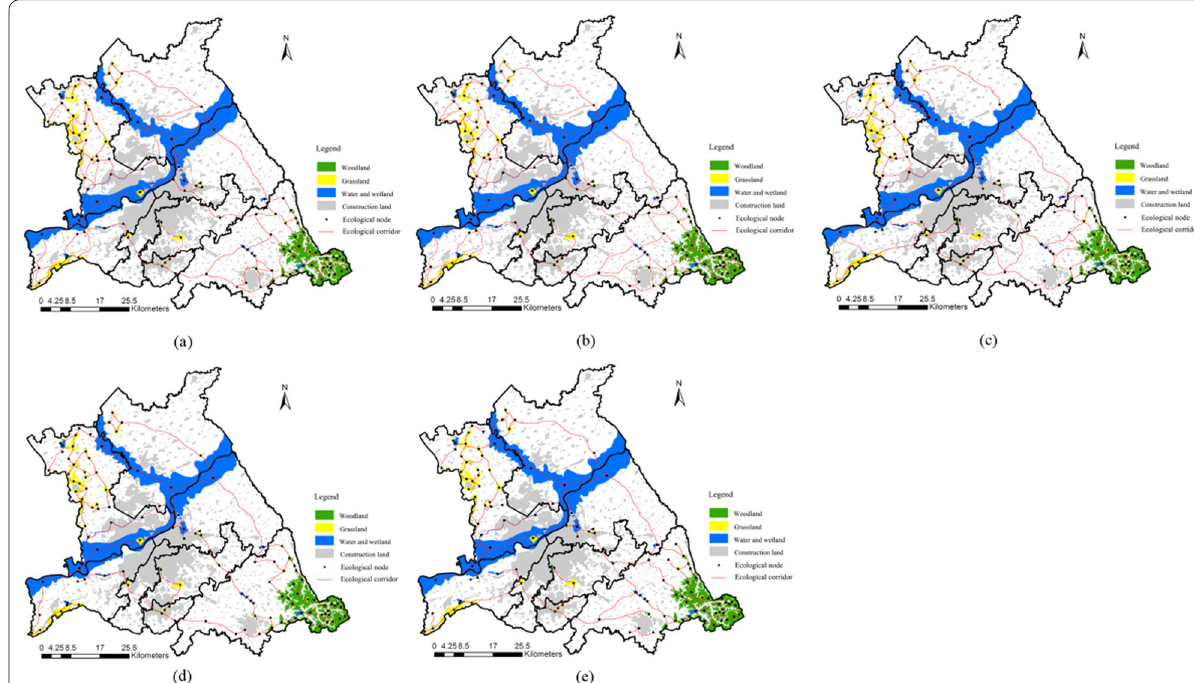
Fig. 8 GI network in multiple scenarios after optimization. a Current scenario, b 5% economic growth scenario, c 10% economic growth scenario, d 15% economic growth scenario, e 20% economic growth